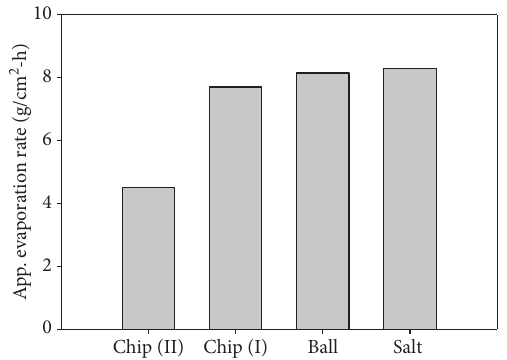
Figure 4: Comparison of apparent evaporation rates of LiCl-KCl eutectic salt in various surrogate deposits.